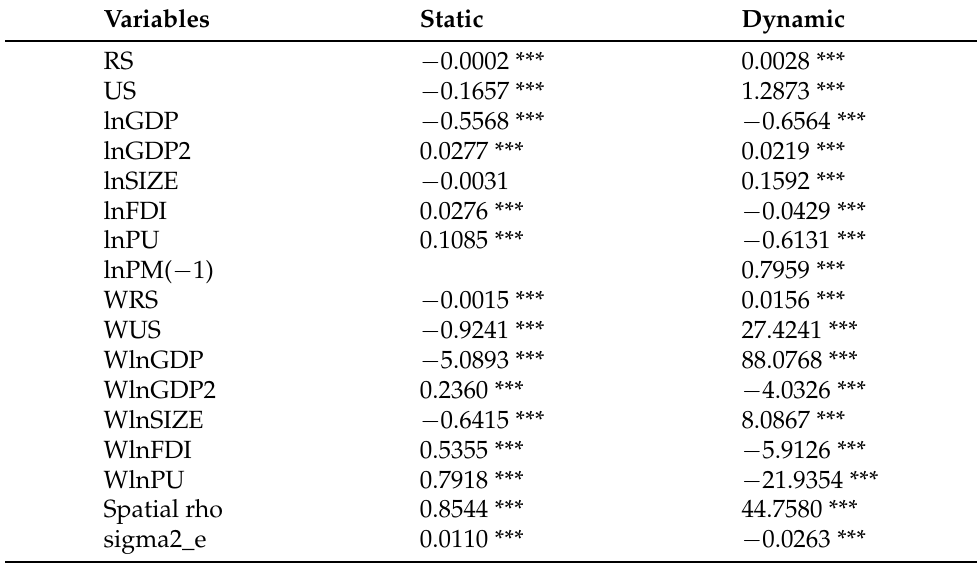
Table 10. SDM parameter estimation.